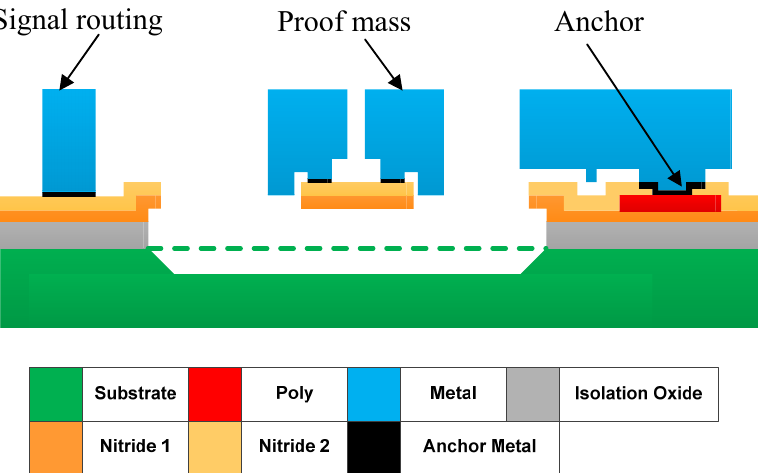
Figure 7. Cross-sectional view of the structures of a released accelerometer with color code for each layer (not to scale) involved. For dimensions of each layer, please refer to Table